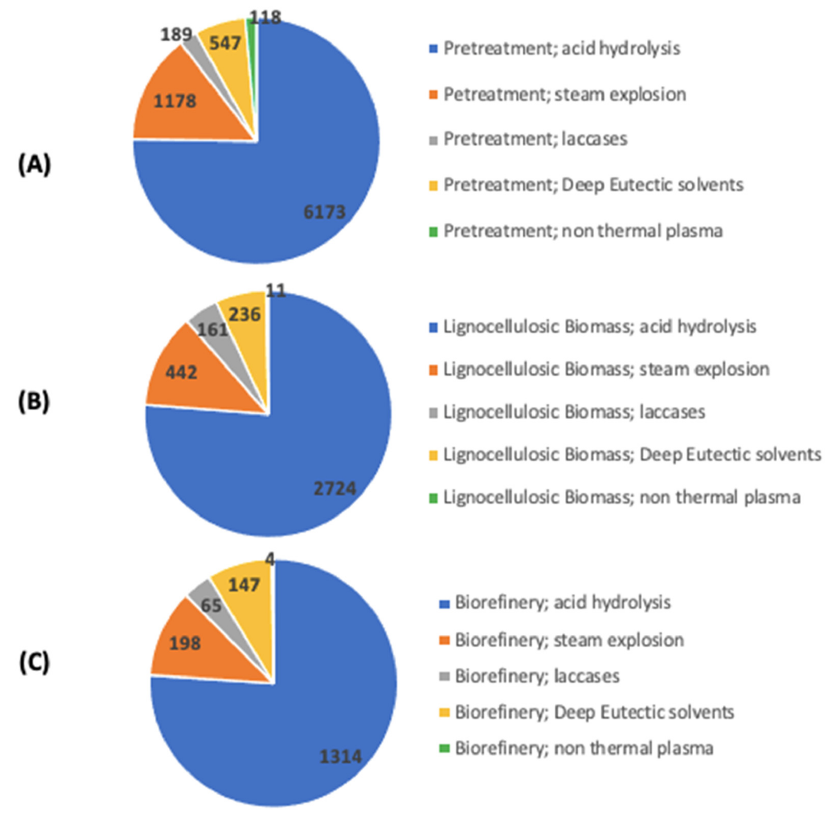
Figure 2. The number of studies in the literature on several biomass pretreatments using different keywords: ( A ) pretreatment; ( B ) lignocellulosic biomass; ( C )